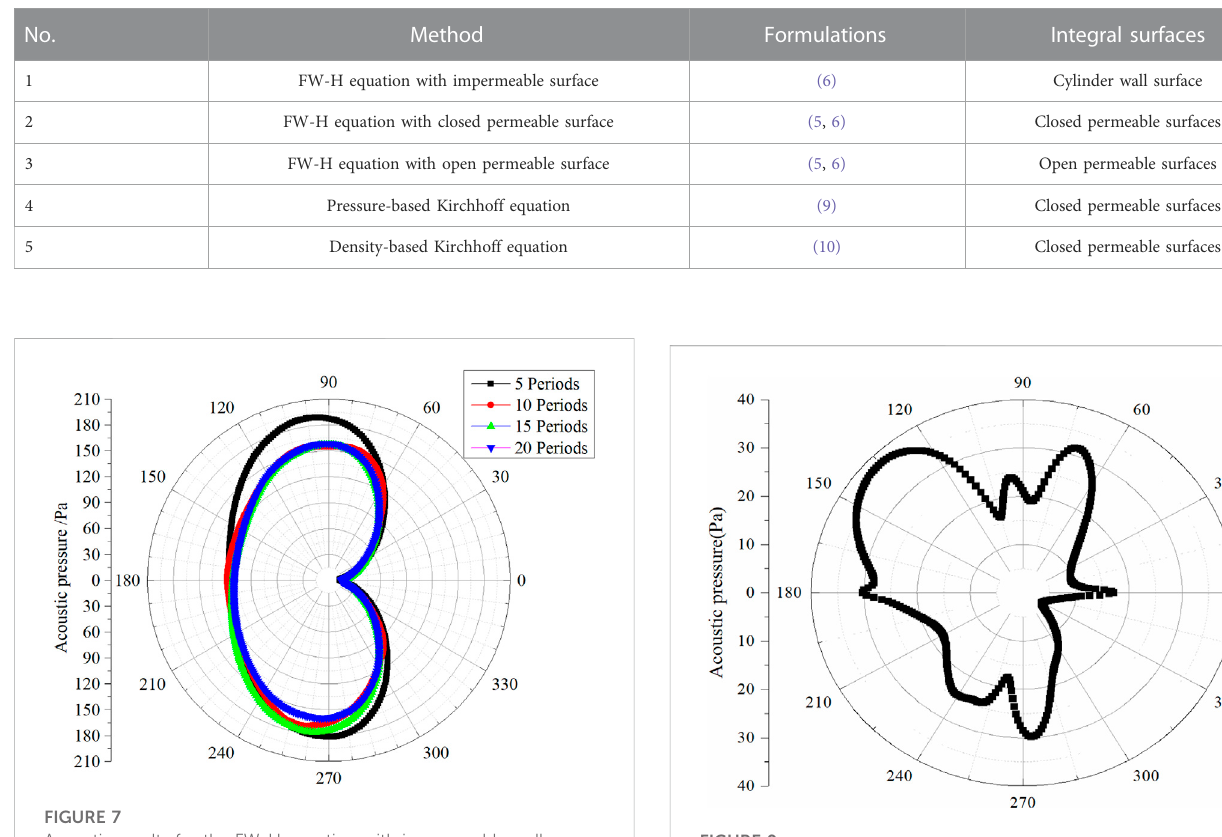
FIGURE 9 Acoustic results for the FW-H equation with open permeable integral surfaces.